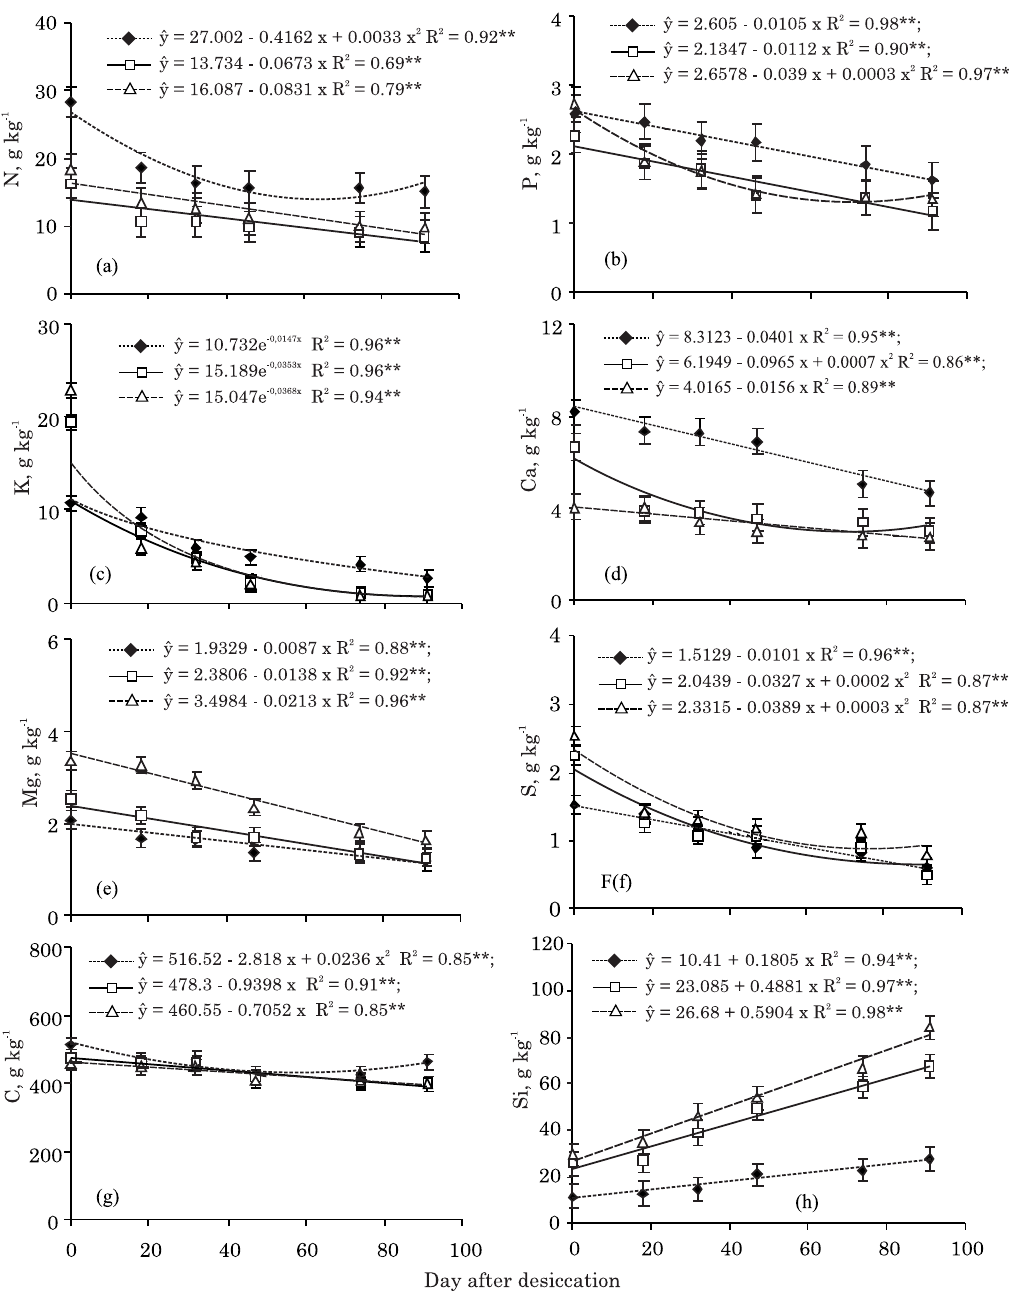
Figure 3. N (A), P (B), K (C), Ca (D), Mg (E), S (F), C (G) and Si (H) concentration of pigeonpea ( ), pigeonpea+pearl millet ( ) and pearl millet ( ) shoot dry matter according to time after desiccation.** significant at 1 % by the F test. Vertical bars indicate the value of LSD at 5 % by the Tukey